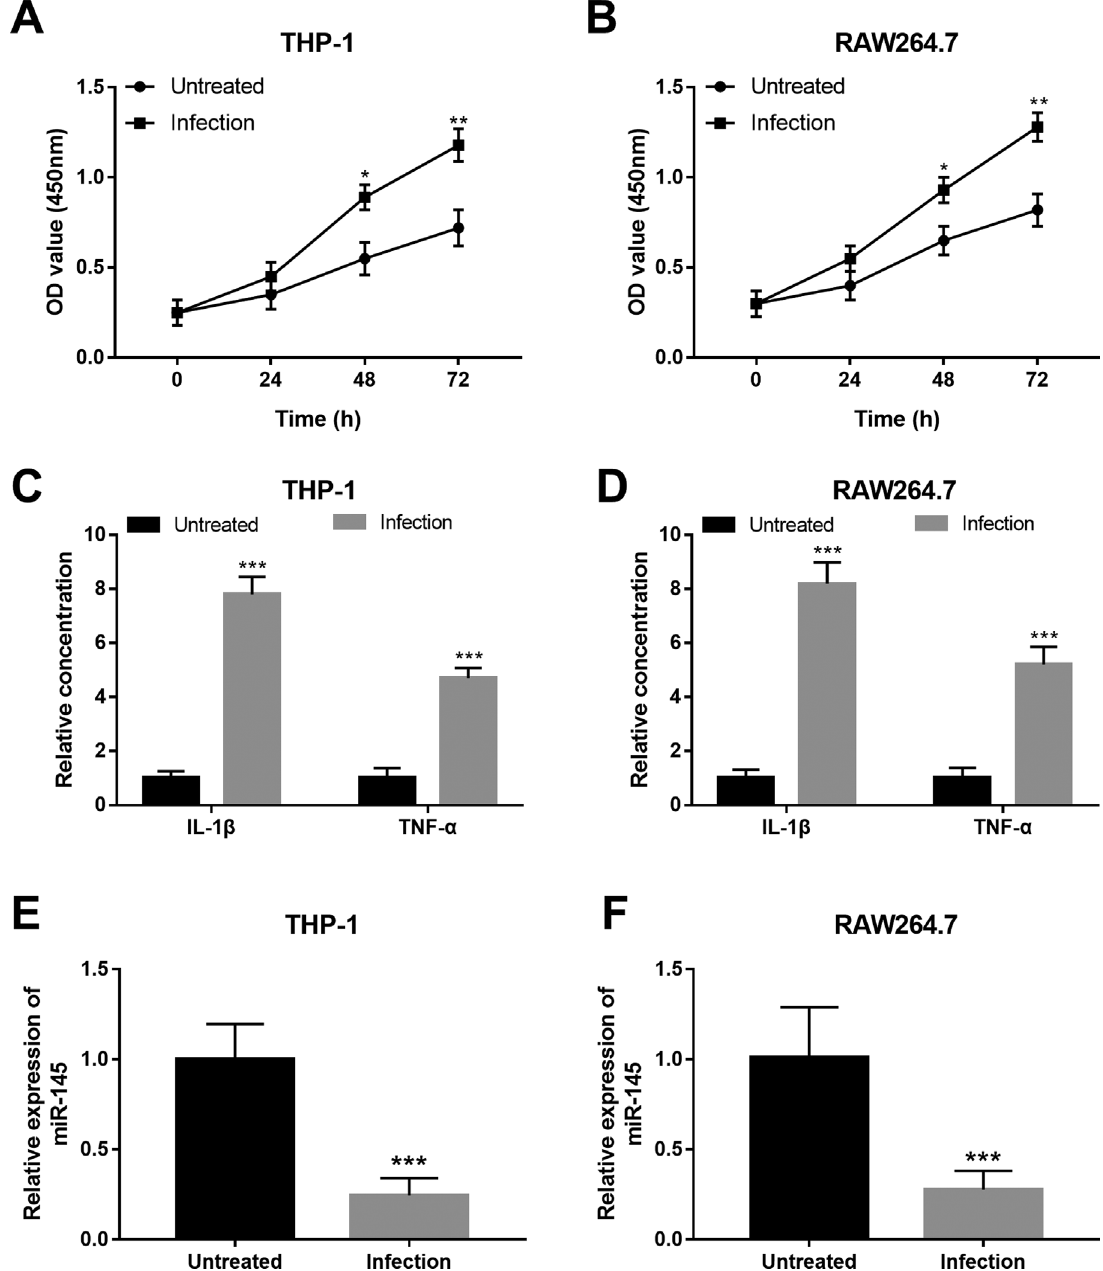
Figure 3 - Effects of Mtb infection on cell viability, inflammatory responses and miR-145 expression in human macrophage THP-1 and murine macrophage RAW264.7 cells. A and B. The infected macrophage cell viability was promoted compared with the untreated cells. C and D. The inflamma- tory reaction was activated in the macrophages by Mtb infection. E and F. Expression of miR-145 was suppressed in the macrophages after the infection with Mtb. * P < 0.05, ** P < 0.01, *** P < 0.001 vs.